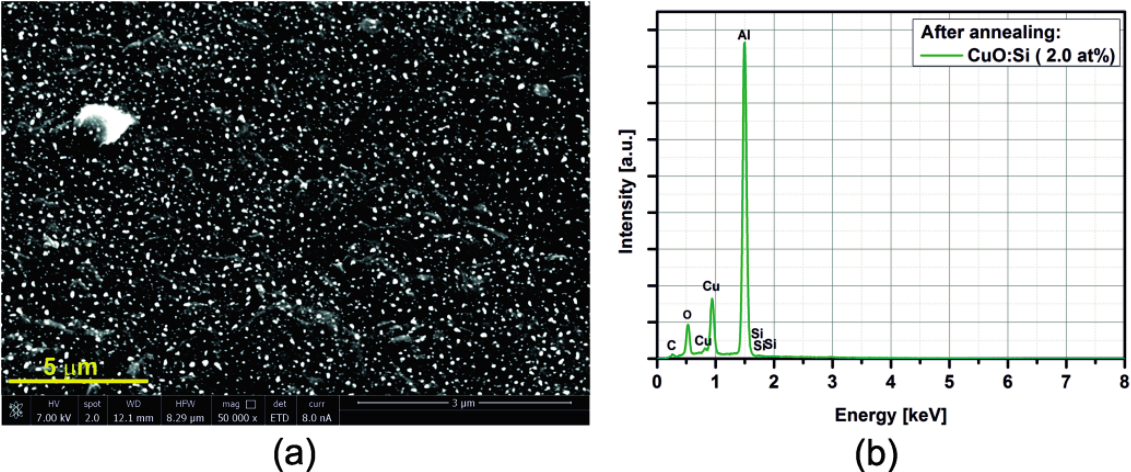
Figure 11. ( a ) SEM image; ( b ) EDX distribution of the Si:CuO-based sensor (Si: 2.0 at%).